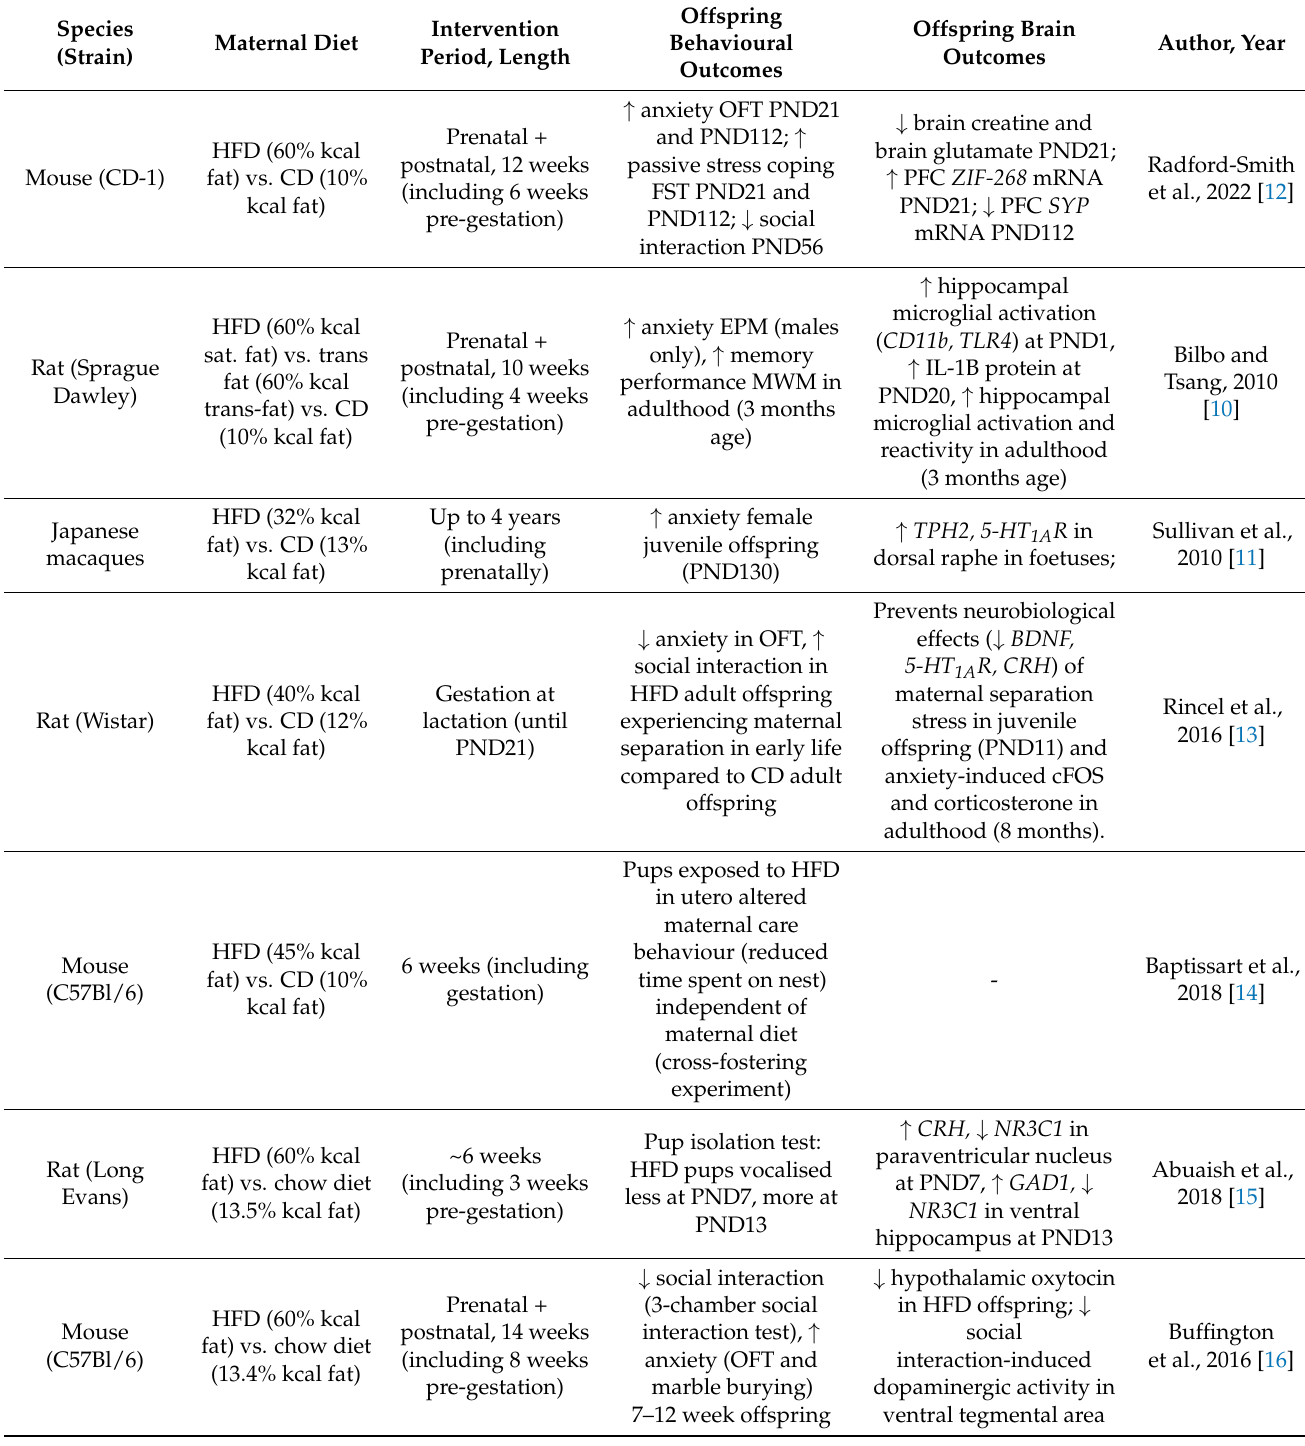
Table 1. Overview of preclinical studies investigating mechanisms of maternal-diet-induced obesity on the offspring brain and